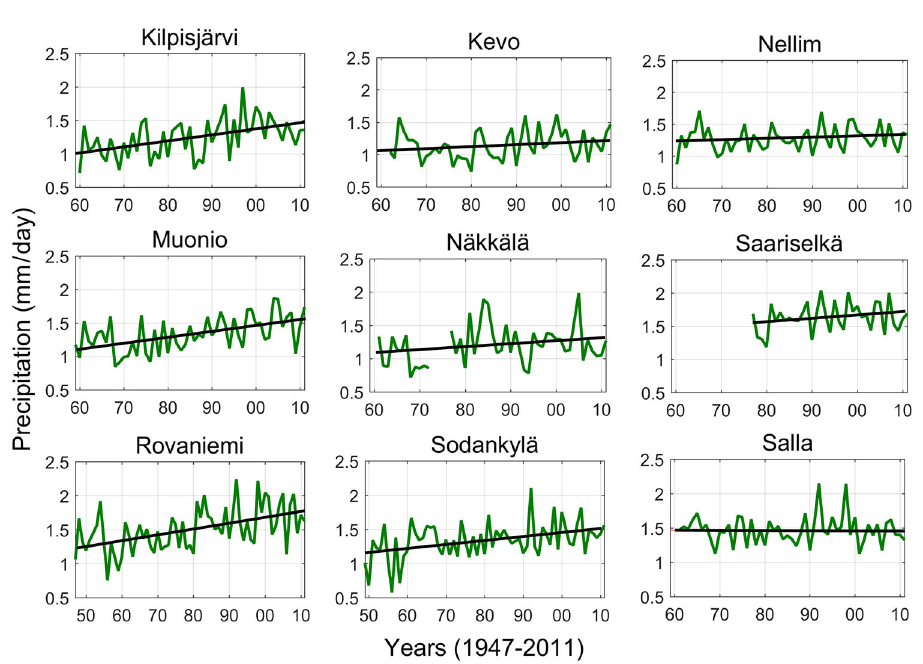
Fig. 5. Long-term variations in mean annual precipitation at the Lapland